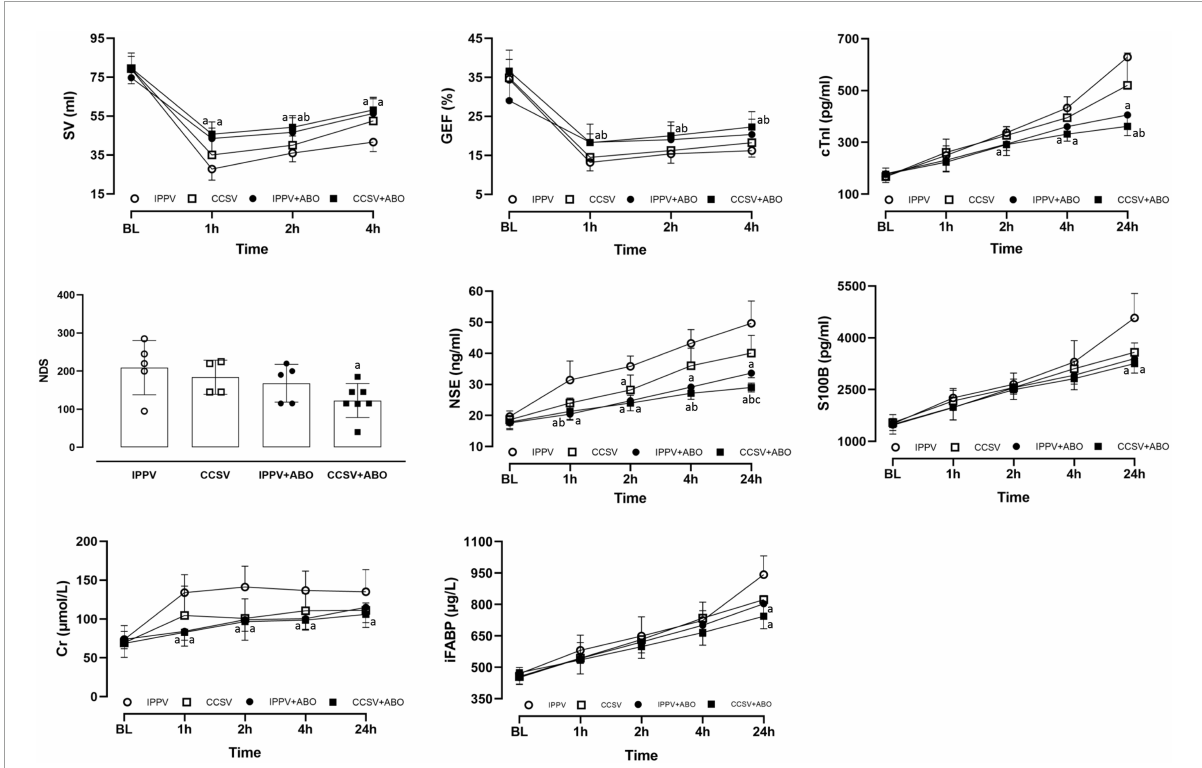
FIGURE4 The changes of stroke volume (SV), global ejection fraction (GEF), cardiac troponin I (cTnI), neurological deficit score (NDS), neuron specific enolase (NSE), S100B protein (S100B), creatinine (Cr), and intestinal fatty acid binding protein (IFABP) at baseline (BL) and after resuscitation. IPPV, intermittent positive pressure ventilation; CCSV, chest compression synchronized ventilation; ABO, aortic balloon occlusion. Each group contained 7–10 swine at BL, and 4–7 swine after resuscitation, respectively. a P < 0.05 for CCSV + ABO group, IPPV + ABO group, CCSV group vs. IPPV group; b P < 0.05 for CCSV + ABO group (right and inferolateral b), IPPV + ABO group (left b) vs. CCSV group; c P < 0.05 for CCSV + ABO group vs. IPPV + ABO